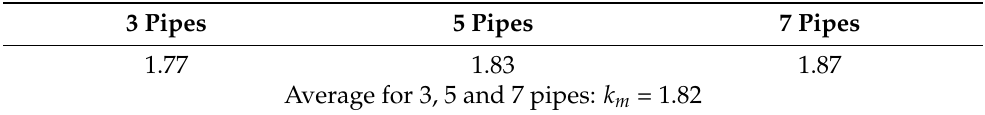
Table 2. Values of total pressure losses coefficient k m